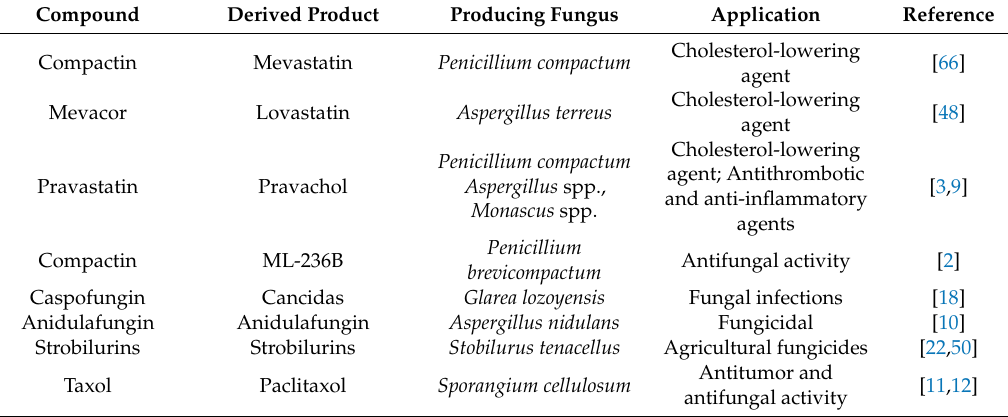
Figure 3. Some important bioactive compounds from endophytic fungi. Table 1. Some US Food and Drug Administration (FDA)-approved drugs from